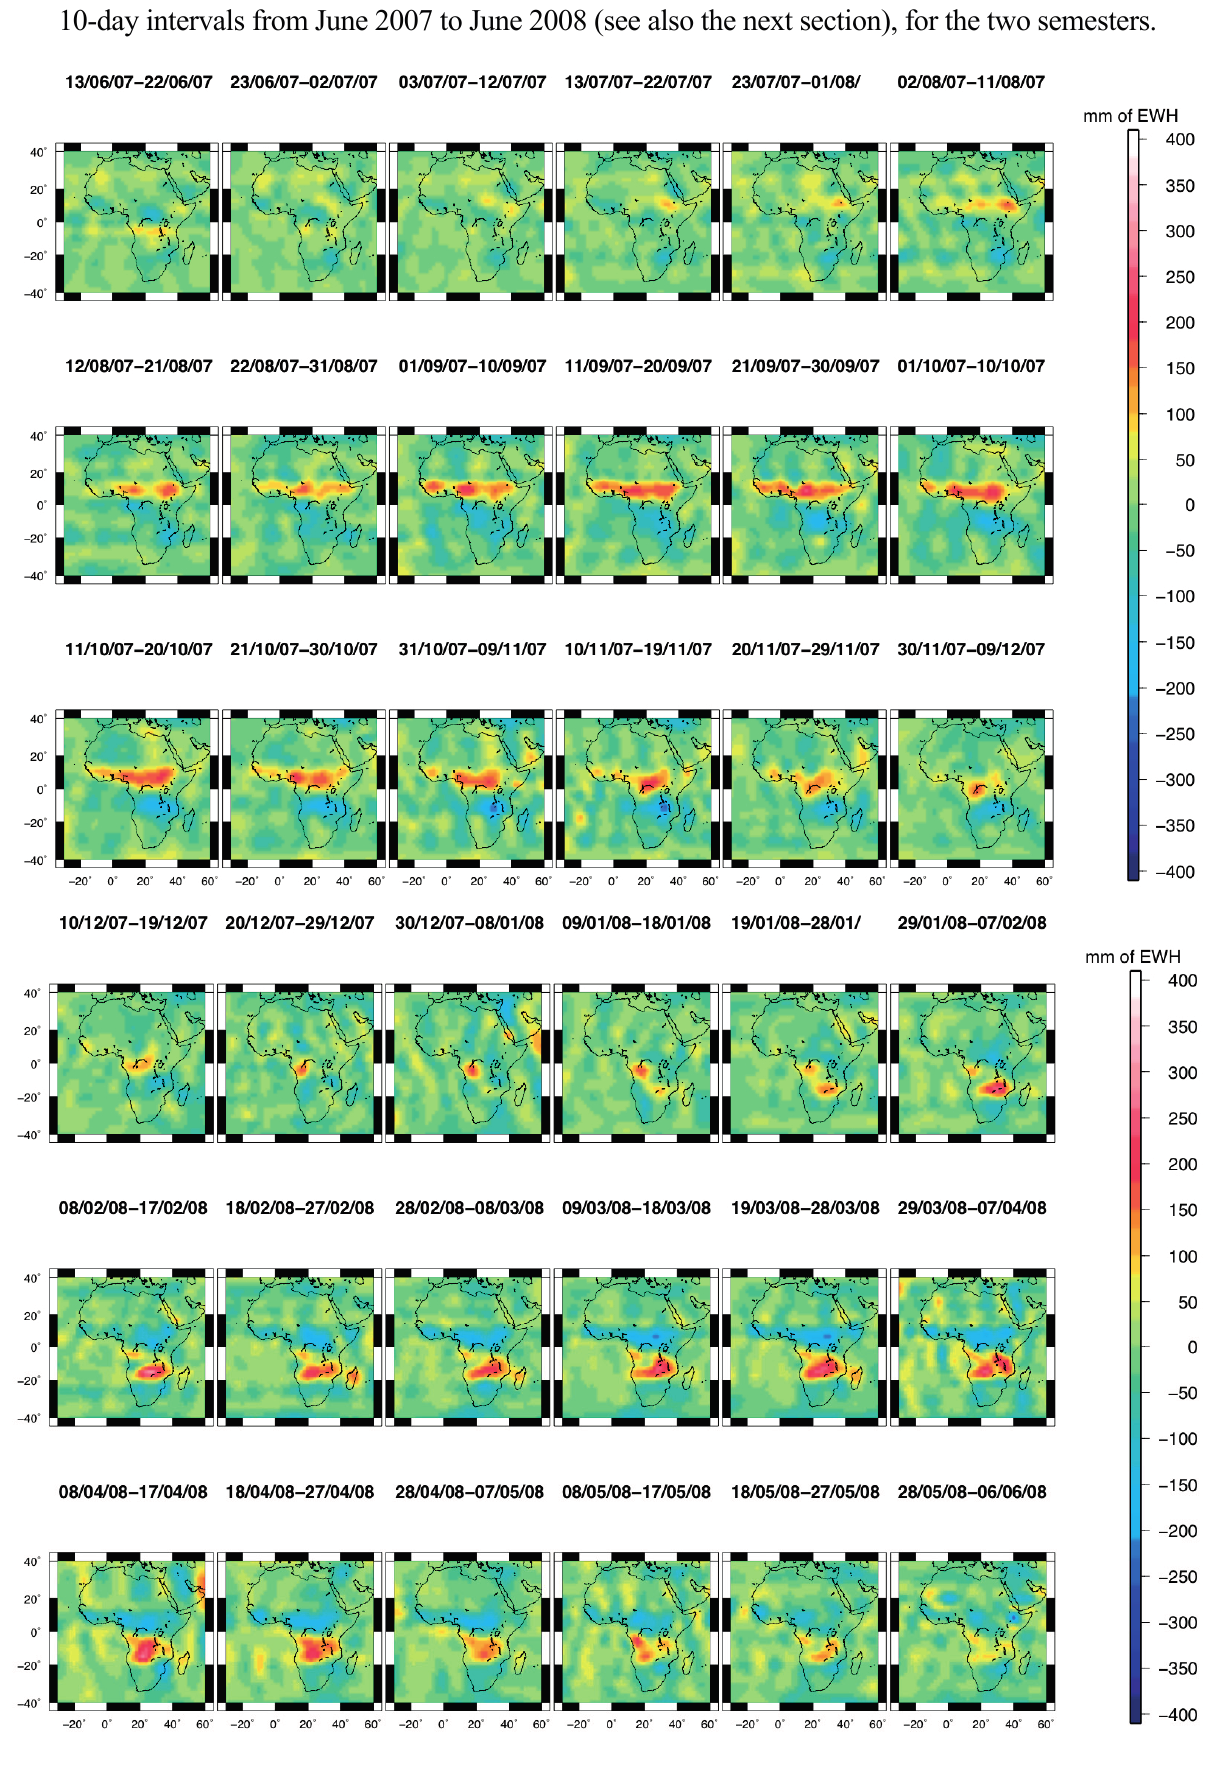
Figure 3. Example of one-year series of regional maps of water mass changes presented at 10-day intervals from June 2007 to June 2008 (see also the next section), for the two